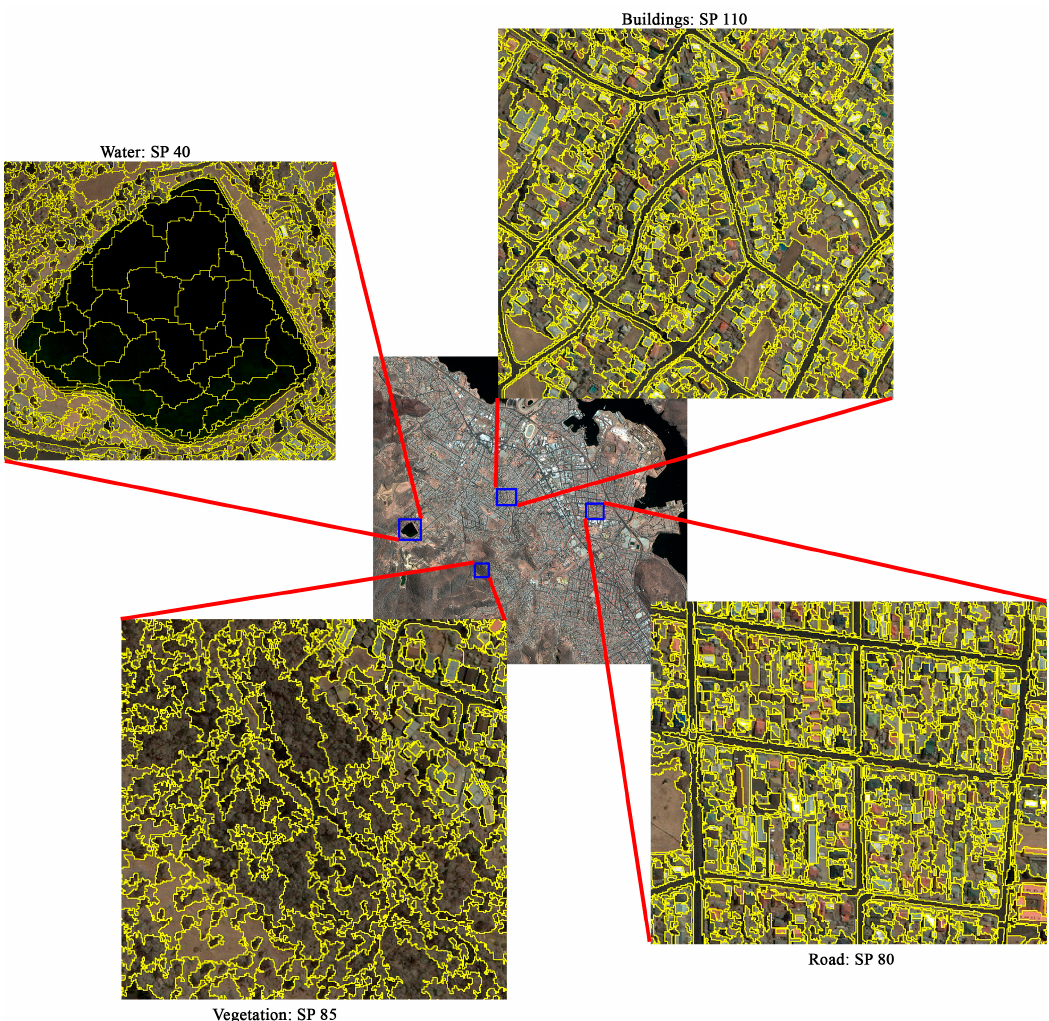
Figure 7. Segmentation results of the building, vegetation, road, and water classes in the 1-m test image.